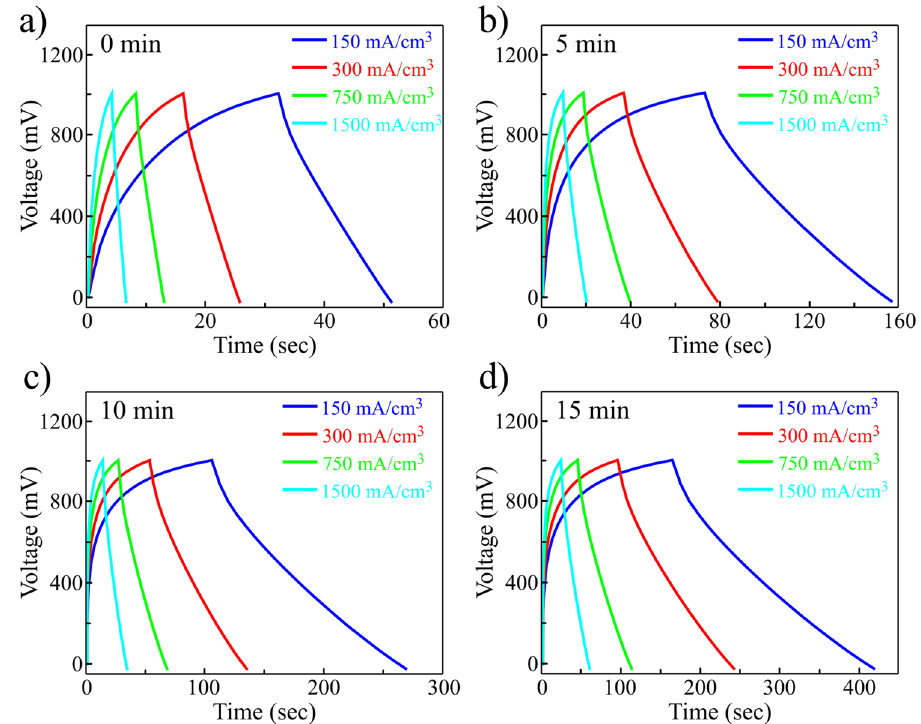
Figure 8. Charge–discharge curves of r(F + O)rGO supercapacitors with SF 6 + O 2 plasma exposure times of ( a ) 0 min, ( b ) 5 min, ( c ) 10 min, and ( d ) 15 min tested in PVA + H 2 SO 4 electrolyte.